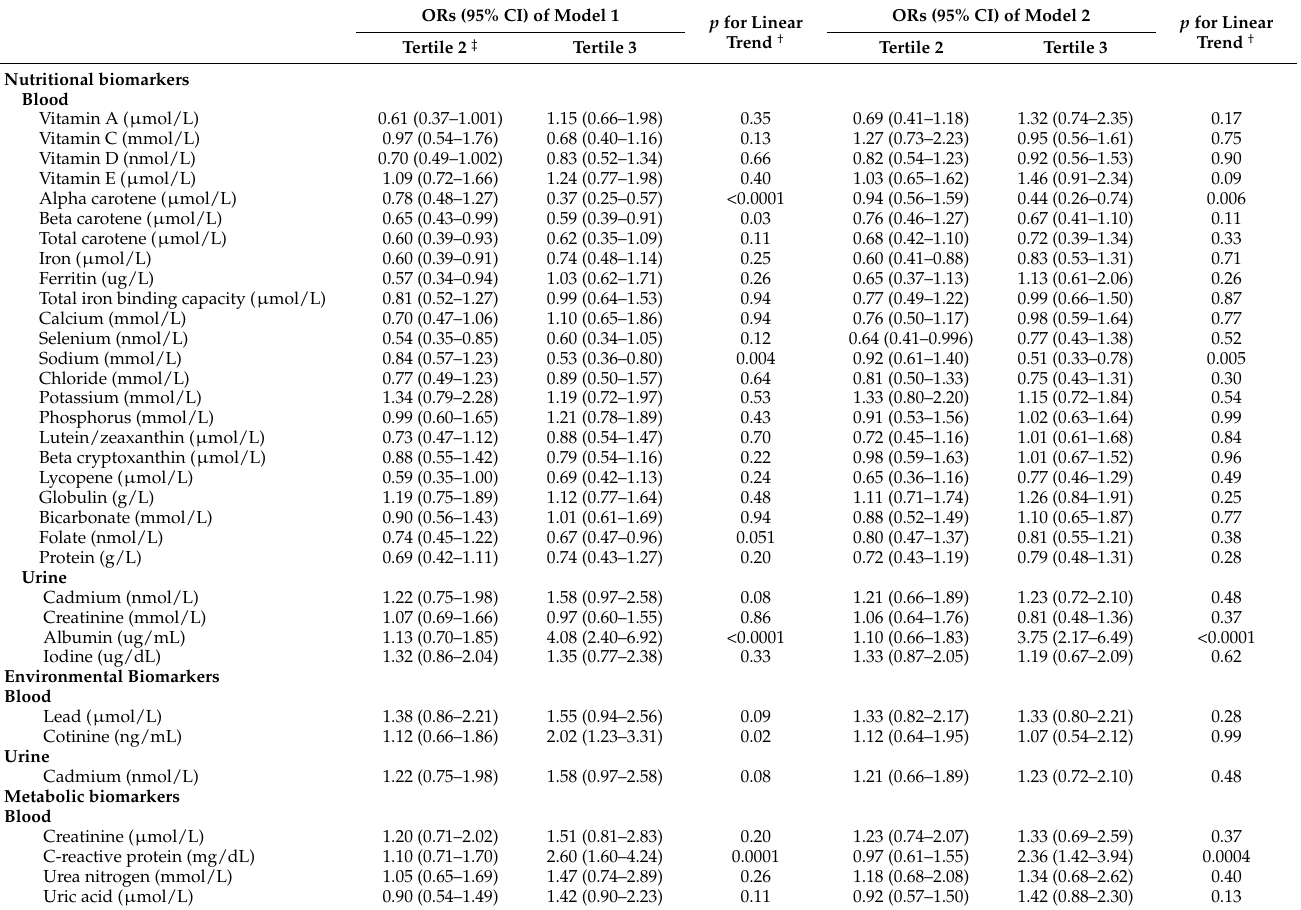
Table 2. Multivariable-adjusted ORs and 95% CIs of all-cause mortality by tertiles of different biomarkers